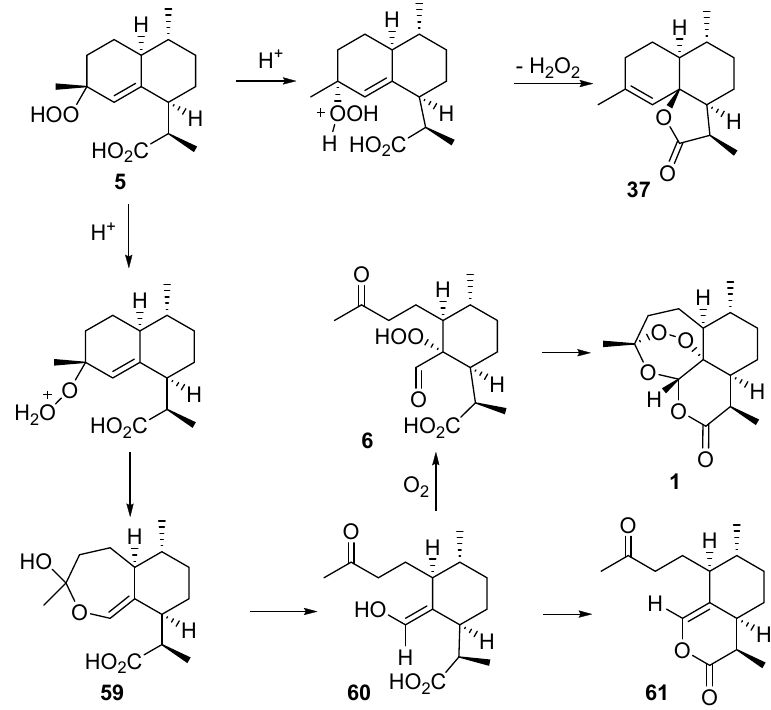
Scheme 14. Acid-catalyzed reaction steps in the formation of artemisinin and side products. A continuous-flow process for the synthesis of artemisinin ( 1 ) from dihydroartemisinic acid ( 4 ), which does not require isolation and purification of intermediates, was proposed (Scheme 15)